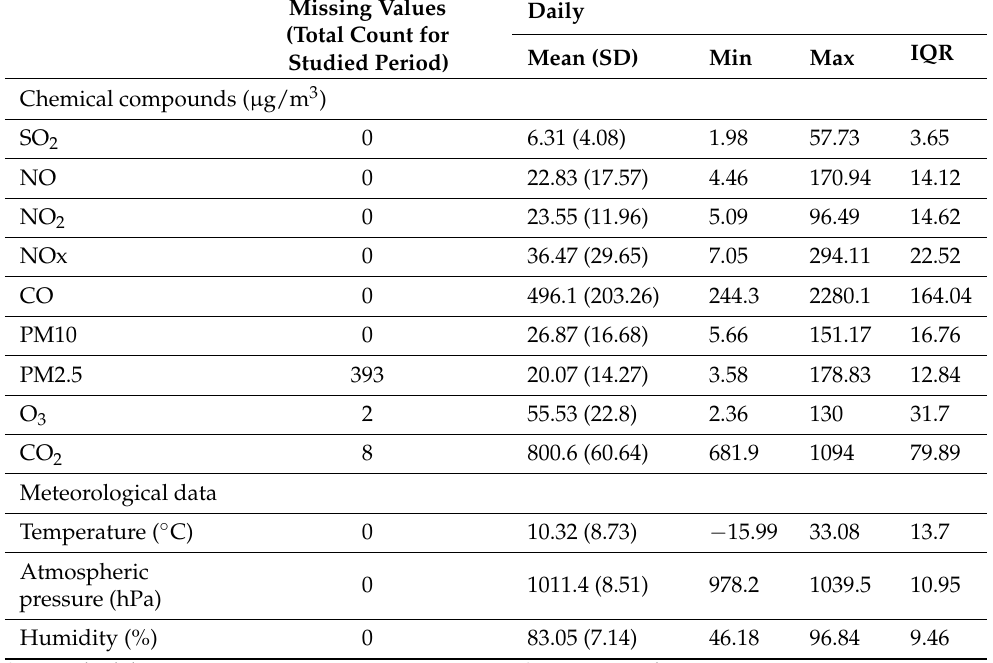
Table 2. Summary of daily environmental conditions in Gdansk agglomeration between 1 January 2014 and 31 December 2018. Missing Values (Total Count for Studied